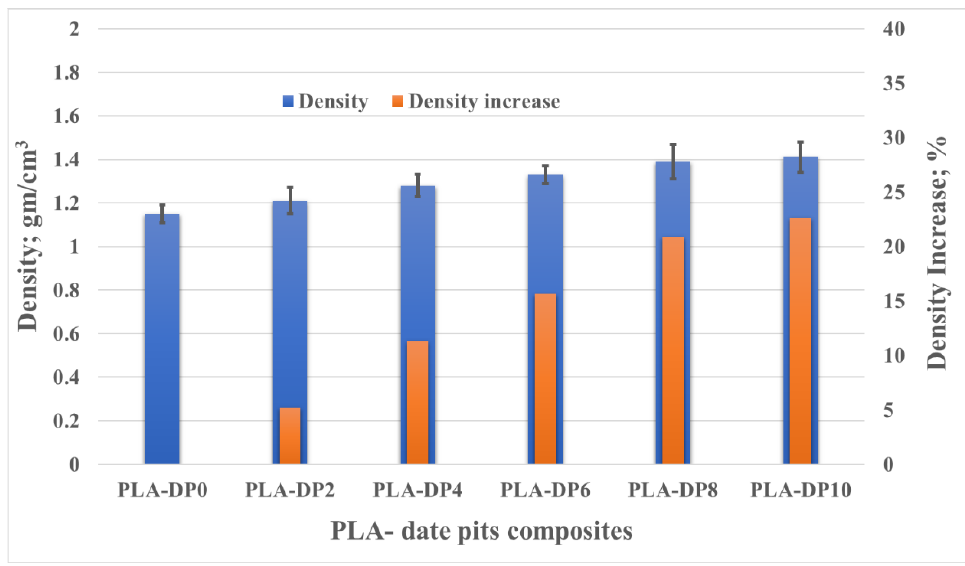
Figure 8. PLA composite density for different date pit contents.